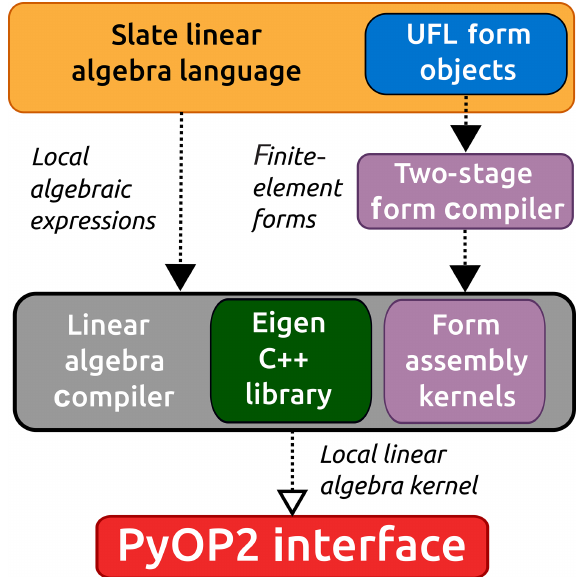
Figure 1. The Slate language wraps UFL objects describing the finite element system. The resulting Slate expressions are passed to a specialized linear algebra compiler, which produces a single macro kernel assembling the local contributions and executes the dense linear algebra represented in Slate. The kernels are passed to the Firedrake’s PyOP2 interface, which wraps the Slate kernel in a mesh-iteration kernel. Parallel scheduling, code generation, and compilation occurs after the PyOP2